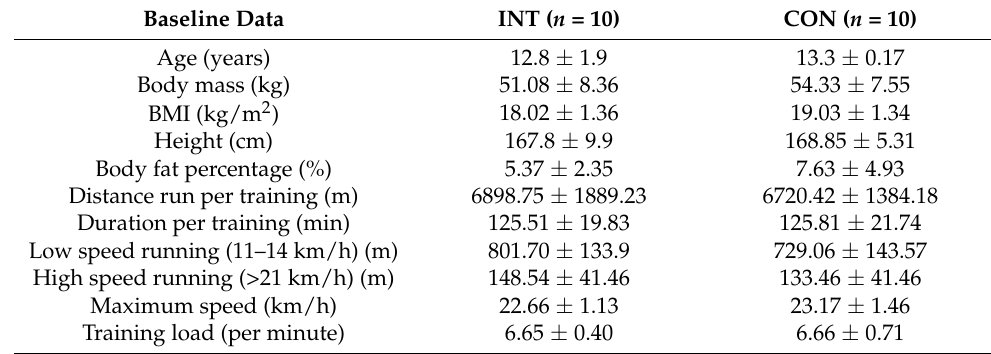
Table 1. Baseline data.